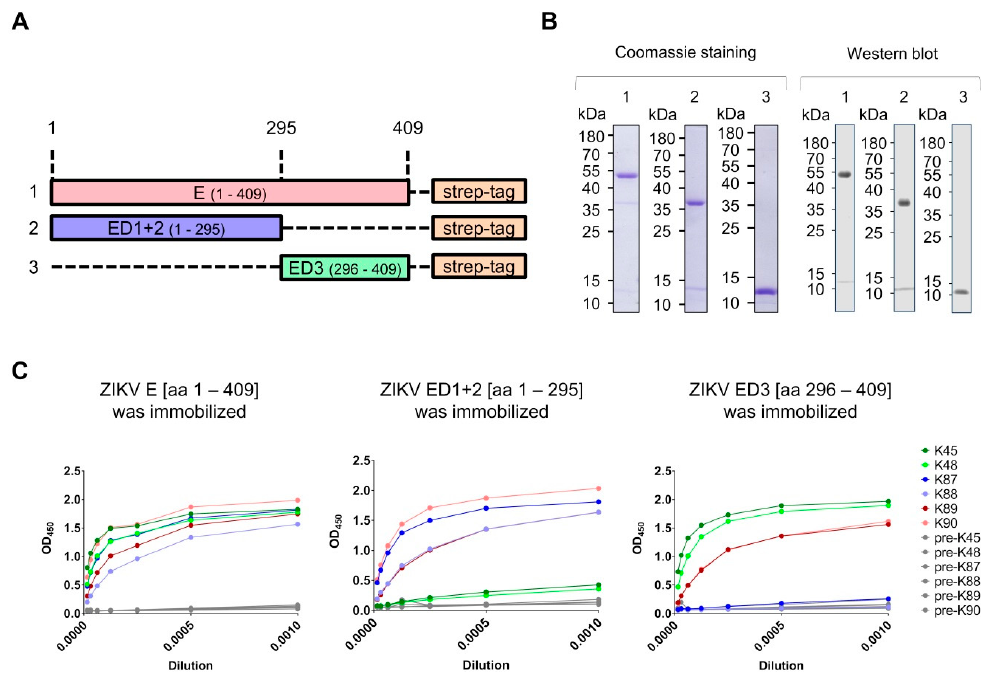
Figure 2. Determination of ZIKV E-specific antibodies in the sera. ( A ) Schematic diagram of the designed constructs, which were used for antibody characterization (and later for antibody purification). The constructs were designed for the production of strep-tagged-ZIKV E protein domains; ( B ) Coomassie staining (left) and Western blot (right) of SDS-gels loaded with the purified and refolded strep-tagged ZIKV envelope proteins: (1) ZIKV E, (2) ZIKV ED1 + 2, and (3) ZIKV ED3. The theoretical molecular weights of the purified proteins are: 46, 34, and 14 kDa, respectively. Anti-strep-tag (Novus, Wiesbaden, diluted 1:5000) and anti-mouse antibodies were used as primary and secondary antibodies, respectively; ( C ) Binding capacity of the rabbit sera to the di ff erent ZIKV E domains demonstrated by ELISA. ELISA plates were coated with the strep-tagged-ZIKV E domains and serial dilutions of the hyper-immune and the pre-immune sera were applied. The shown ELISA results represent one of two independent